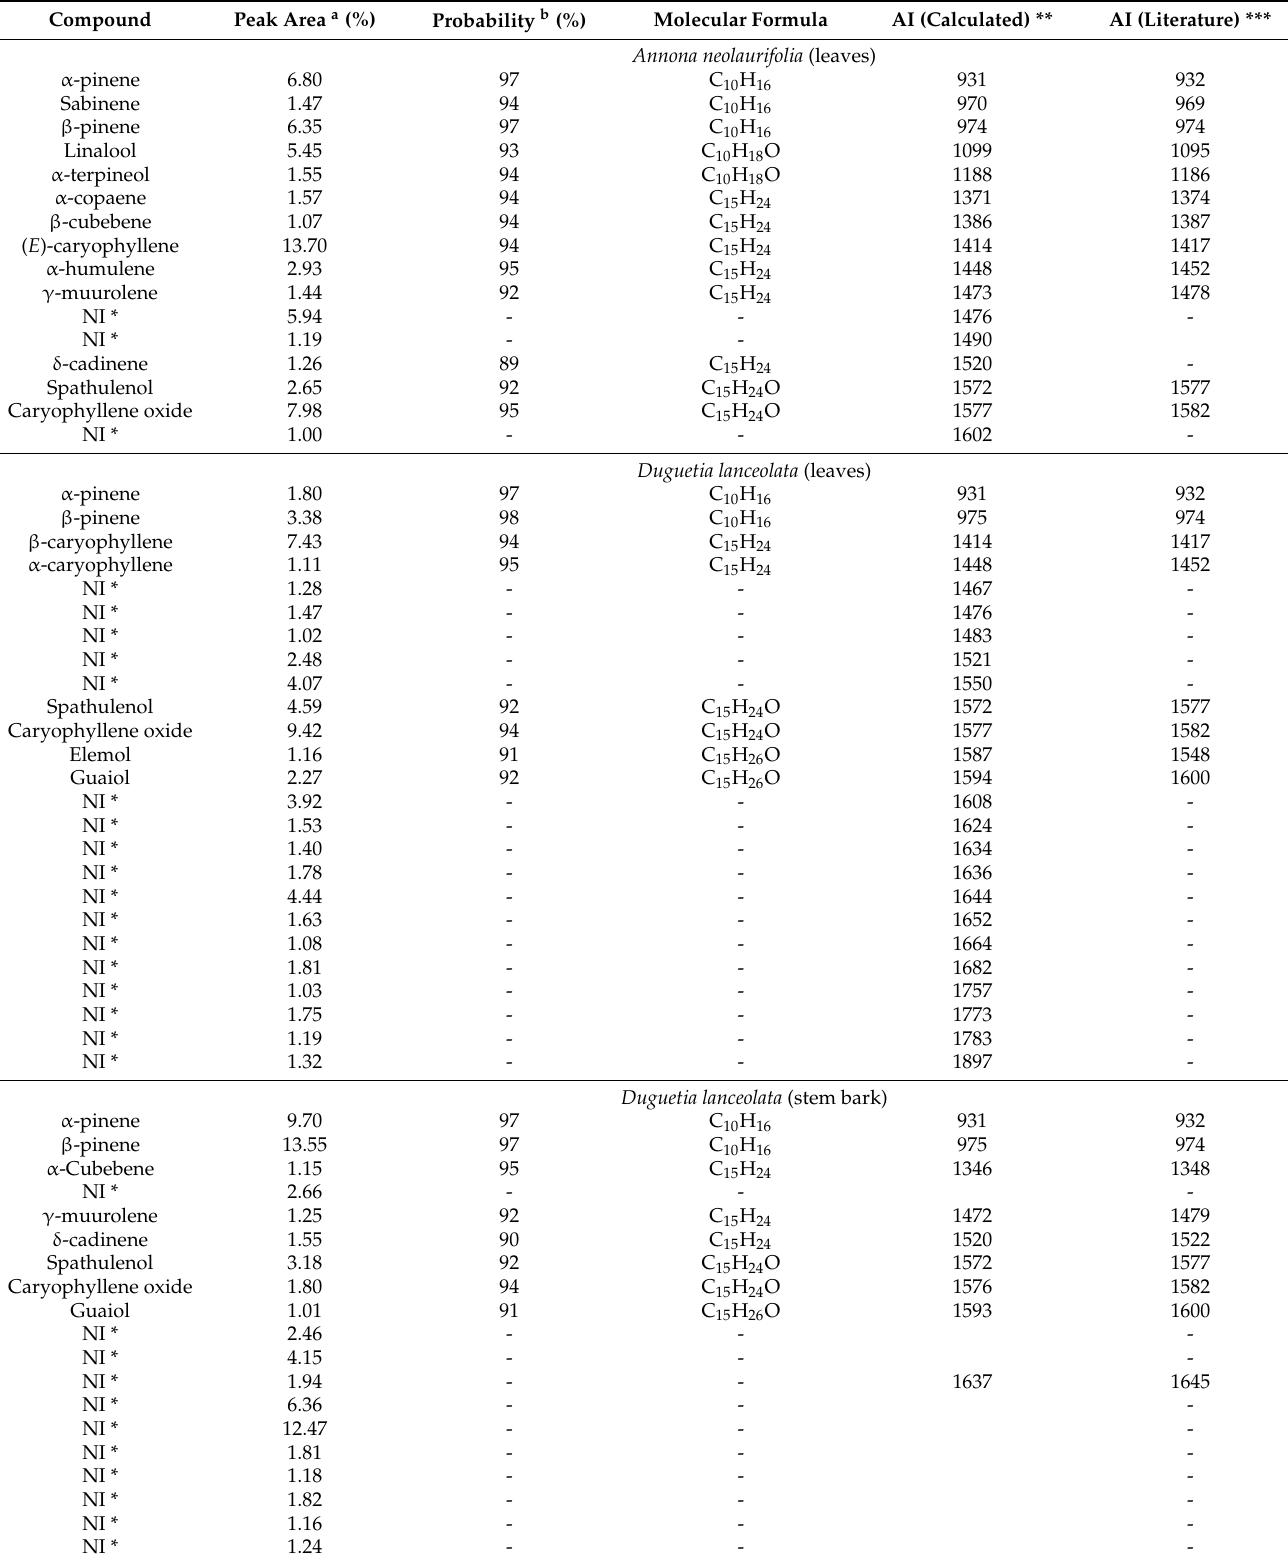
Table 2. Results of the analysis by gas chromatography coupled to mass spectrometry, of essential oils from Annona neolaurifolia (leaves), Duguetia lanceolata (leaves and stem barks), and Xylopia brasiliensis (branches and stem